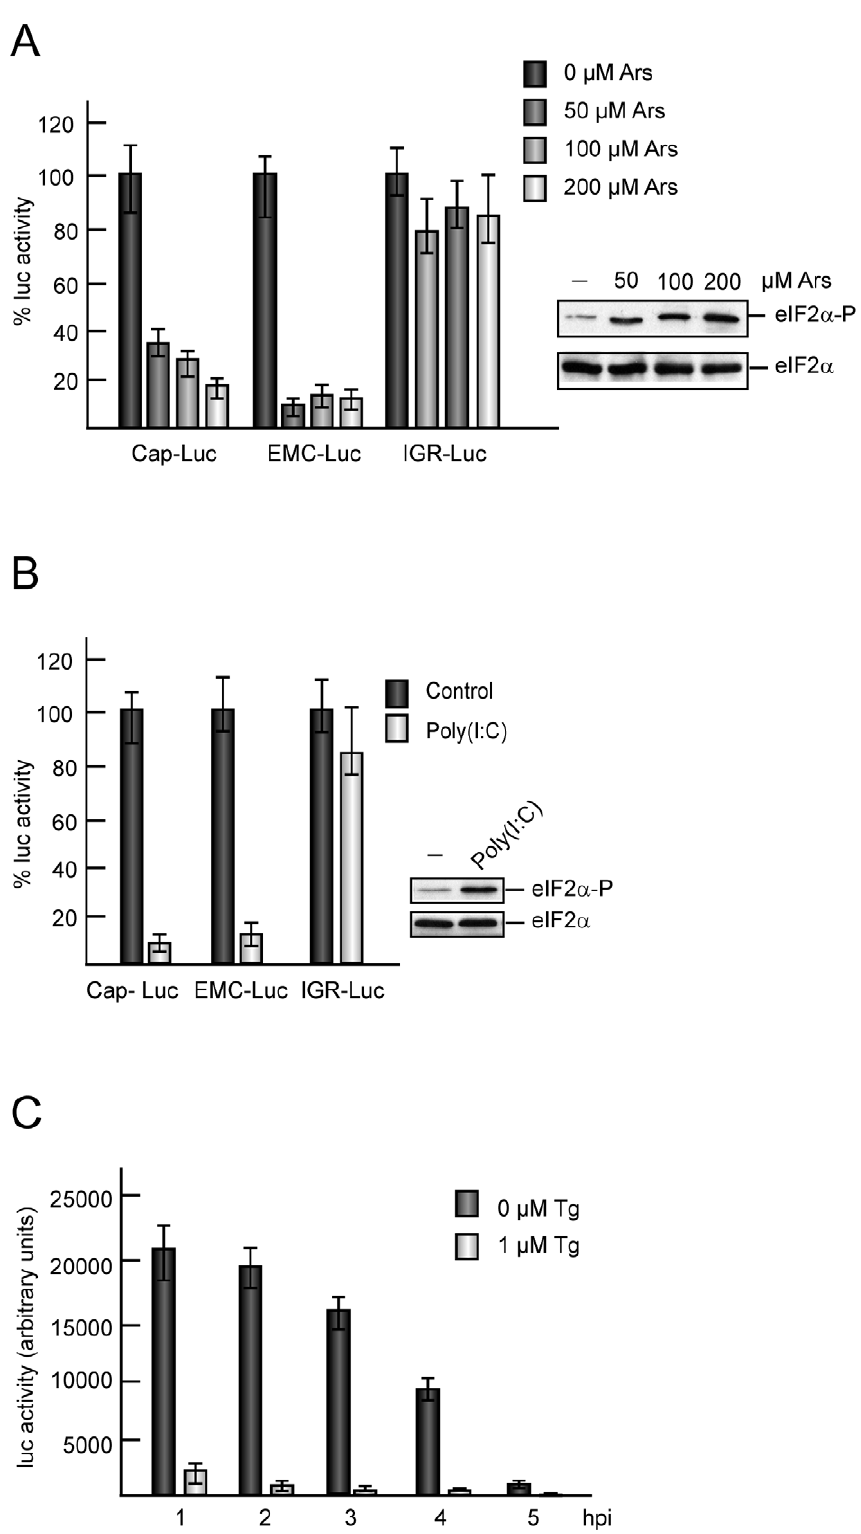
Figure 2. Translation of invitro made mRNAs: Action of eIF2 a phosphorylation. A) Cap-luc, EMC-luc, or CrPV IGR-luc mRNAs synthesized in vitro by T7 RNA polymerase were electroporated in BHK cells and seeded in DMEM (10% FCS). Different amounts of Ars (0, 50, 100 and 200 m M) were added and cells were incubated for 75 min before harvesting to analyze luc activity. The values shown are percentages of the value of their respective Ars untreated samples and are means 6 SD of three independent experiments (left panel). The phosphorylated form of eIF2 a and total eIF2 a were determined in parallel by Western blot employing specific antibodies (right panel). B) Rabbit reticulocyte lysates were pre-treated or not with 0.5 m g/ml poly(I:C) for 30 minutes. Subsequently, 100 ng Cap-luc, EMCV-luc, or CrPV IGR-luc mRNAs were added and incubated for 1 h at 30 u C.